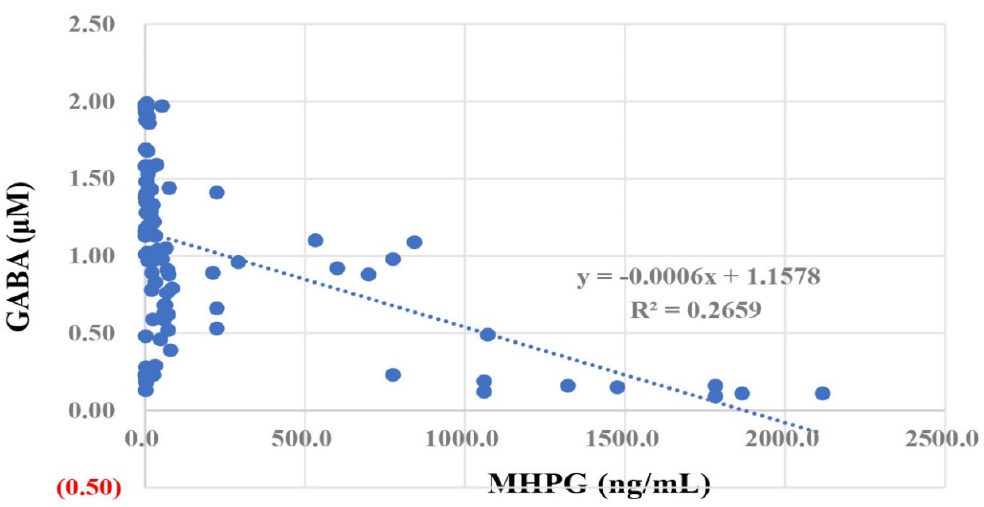
Figure 3. Scatter plot of salivary MHPG (horizontal axis) and GABA (vertical axis). Salivary concentrations of DOPAC ranged from 2.71 to 82.63 ng/mL (23.1 ± 3.1 ng/mL), with no apparent changes associated with walking.